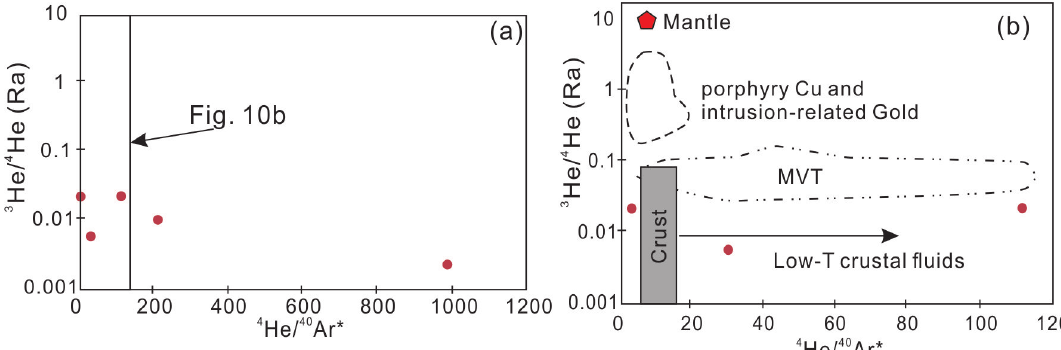
Figure 11. ( a , b ) 3 He/ 4 He versus 4 He/ 40 Ar* plots; Ra: 3 He/ 4 He ratio of atmosphere [47], 40 Ar*: Excess 40 Ar content that is corrected for atmospheric argon; data for Mantle, porphyry Cu, and intrusion-related Au, MVT deposits are from Kendrick and Burnard [48].